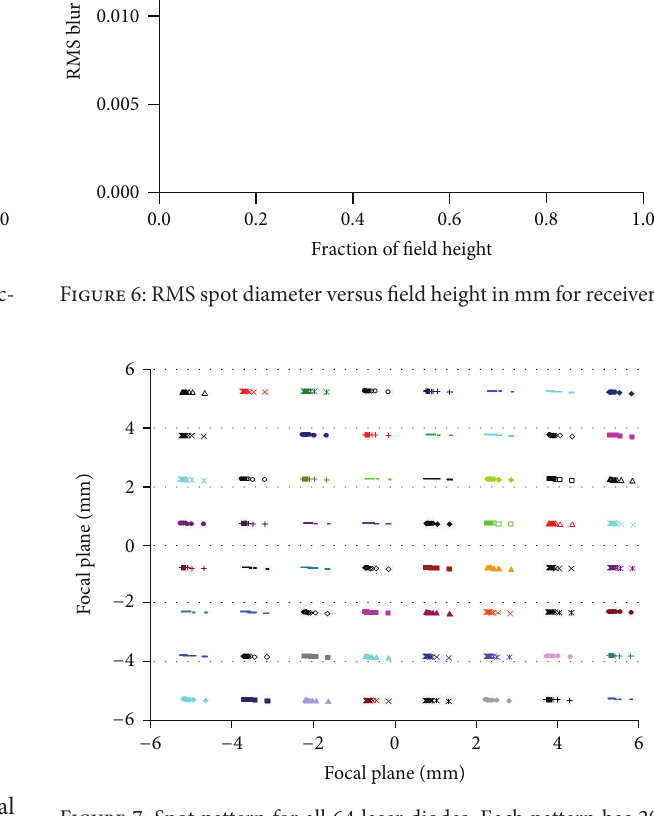
Figure 7: Spot pattern for all 64 laser diodes. Each pattern has 20